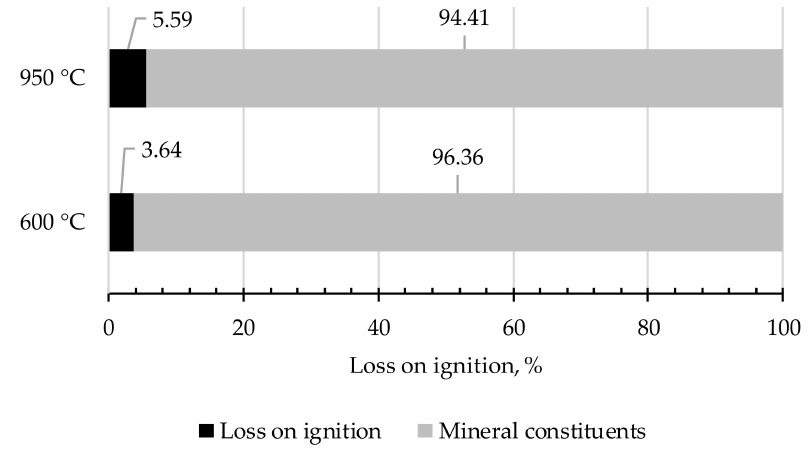
Figure 4. Loss on ignition (LOI) in the tested slag from